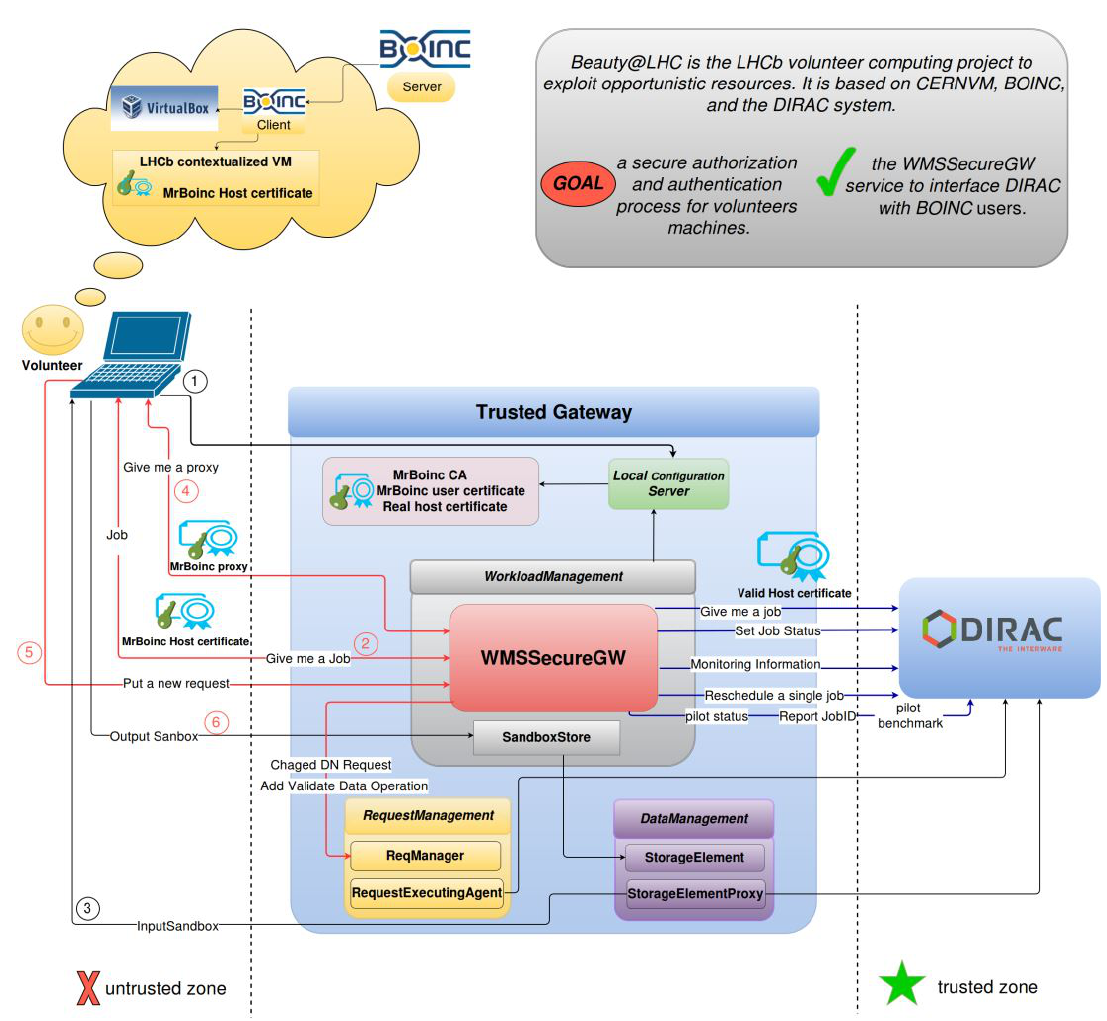
Figure 5: The whole gateway architecture, including the WMSSecureGW service and all services necessary to interface volunteers to the DIRAC